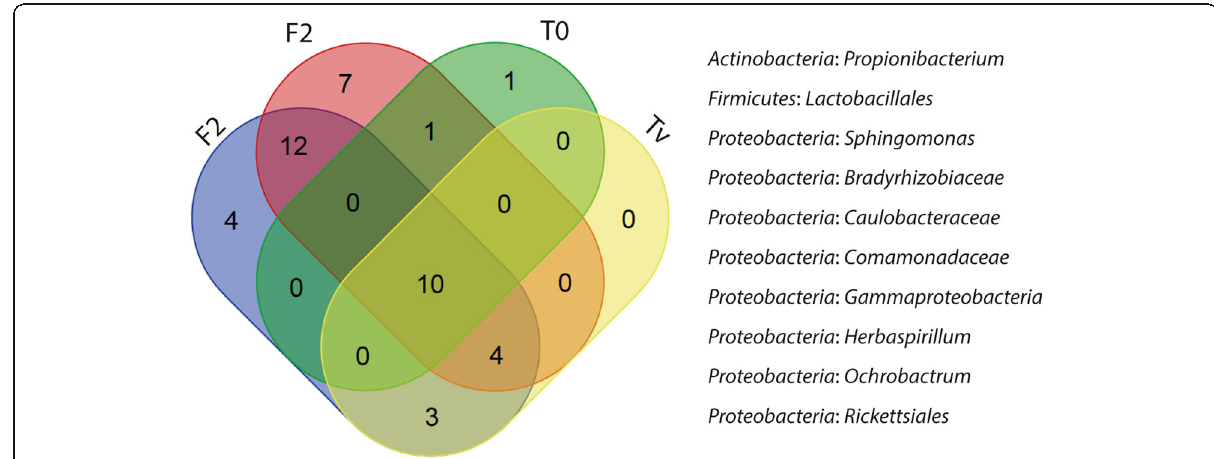
Fig. 3 Venn diagram representing unique and shared Amplicon Single Variants (ASVs) in the gut of rainbow trout fed four different diets ( n = 9 fish/diet). The core microbiome was defined as the ASVs present in all samples, regardless of diet. Only taxa presented in all samples of each group were